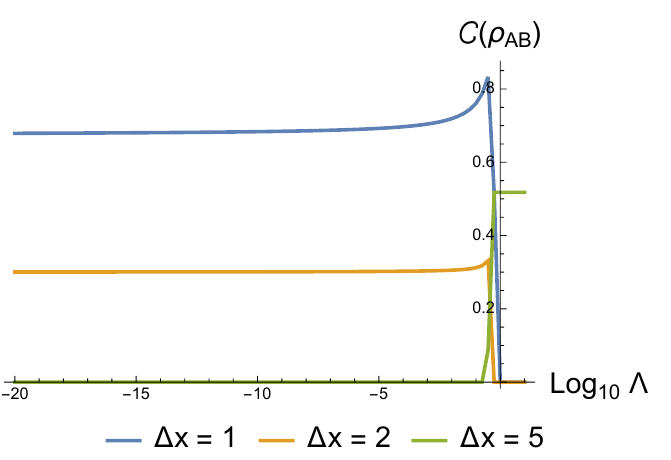
Figure 9 . The concurrence in free space as a function of IR cuto(cid:11) (in logarithmic scale), for (cid:10) = 1 and (cid:27) = 1 in natural units (i.e. (cid:10) (cid:27) = 1 is dimensionless).